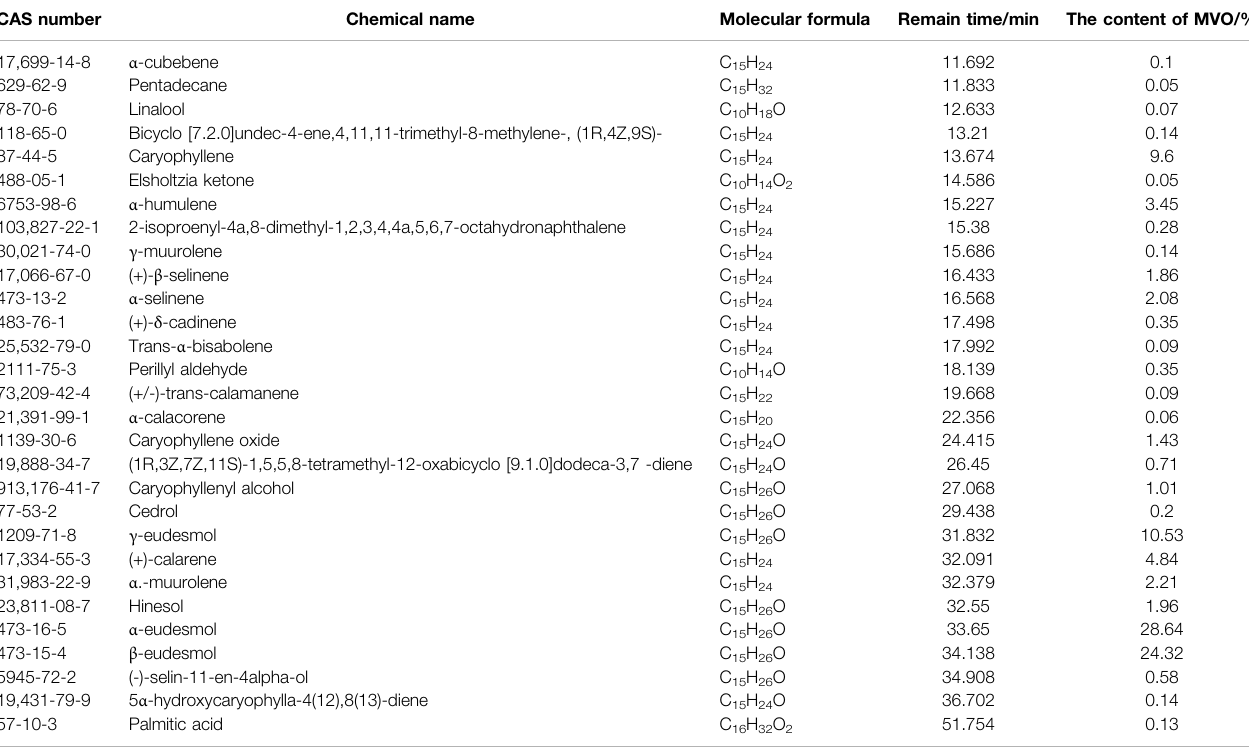
TABLE 1 | The chemical compositions in MVO extracted from the bark of M. of fi cinalis Rehd. et Wils. CAS